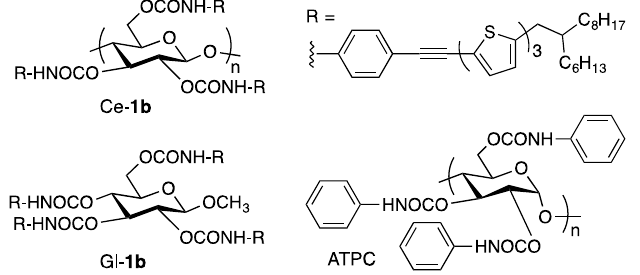
Figure 1. Structures of previously reported phenylcarbamate derivatives of polysaccharides (Ce- 1b and ATPC) and glucose (Gl- 1b ).